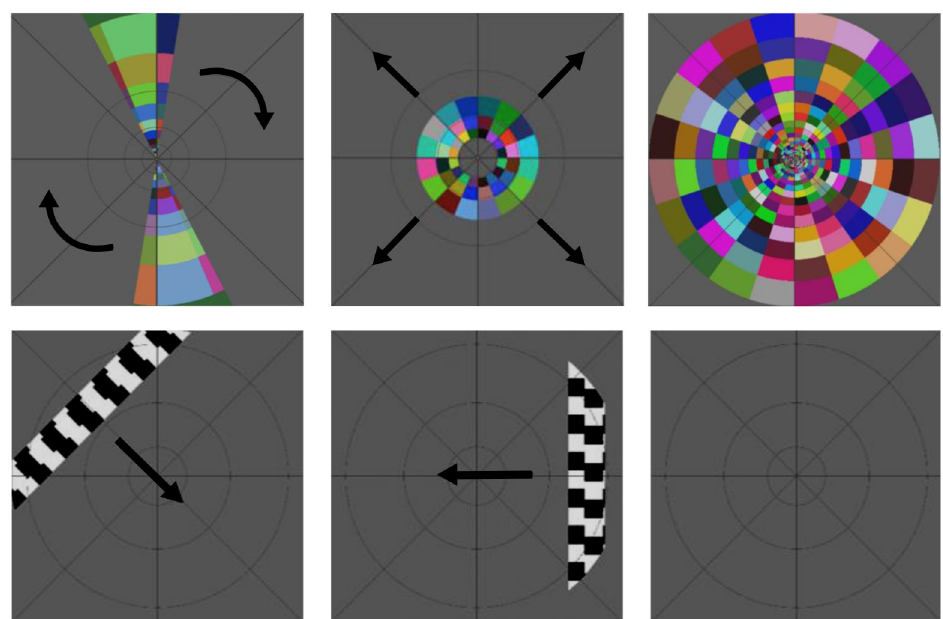
Fig 2. Top Row: Clockwise rotating bowtie, expanding rings and full field flash stimuli. Bottom Row: Drifting bar stimulus at three different time points, showing two of the eight bar directions and a blank luminance block. Arrows indicate the direction of